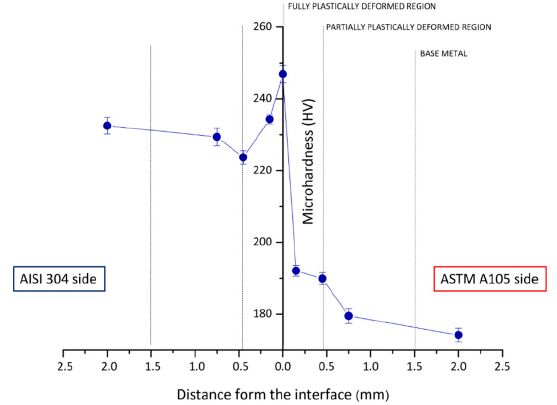
Figure 5. Vickers hardness distribution through the weld interface.